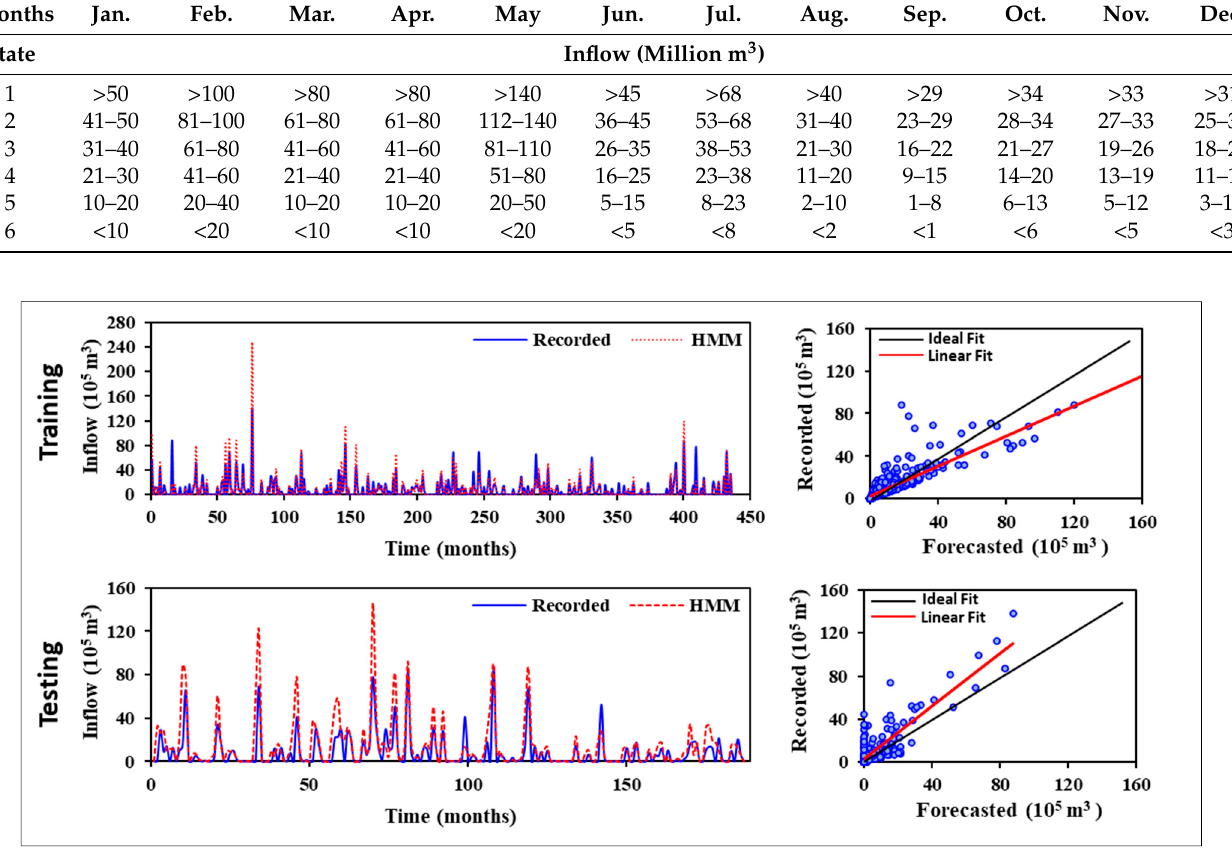
Table 1. Classification of inflow states.